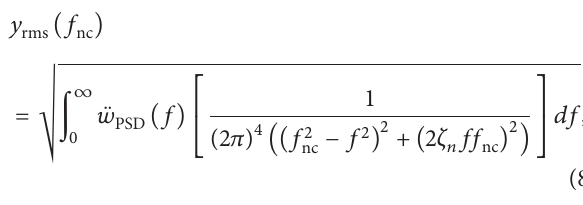
experimental results. Four virtual cracks extensions ( 𝑎 =